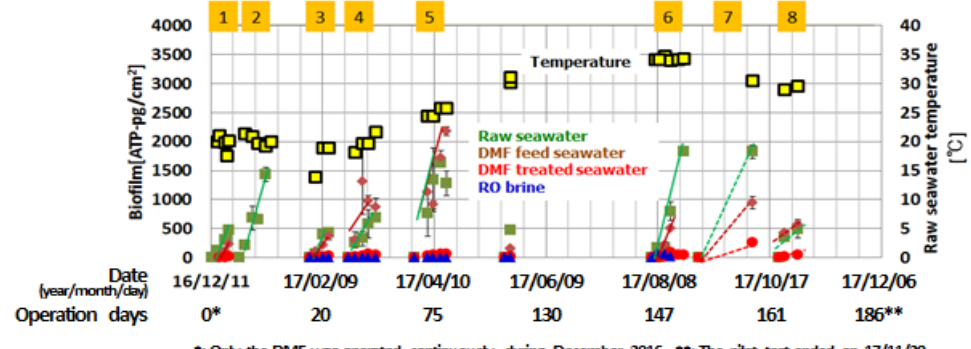
Figure 12. Changes in ΔP 25 of the flat sheet membrane cells.